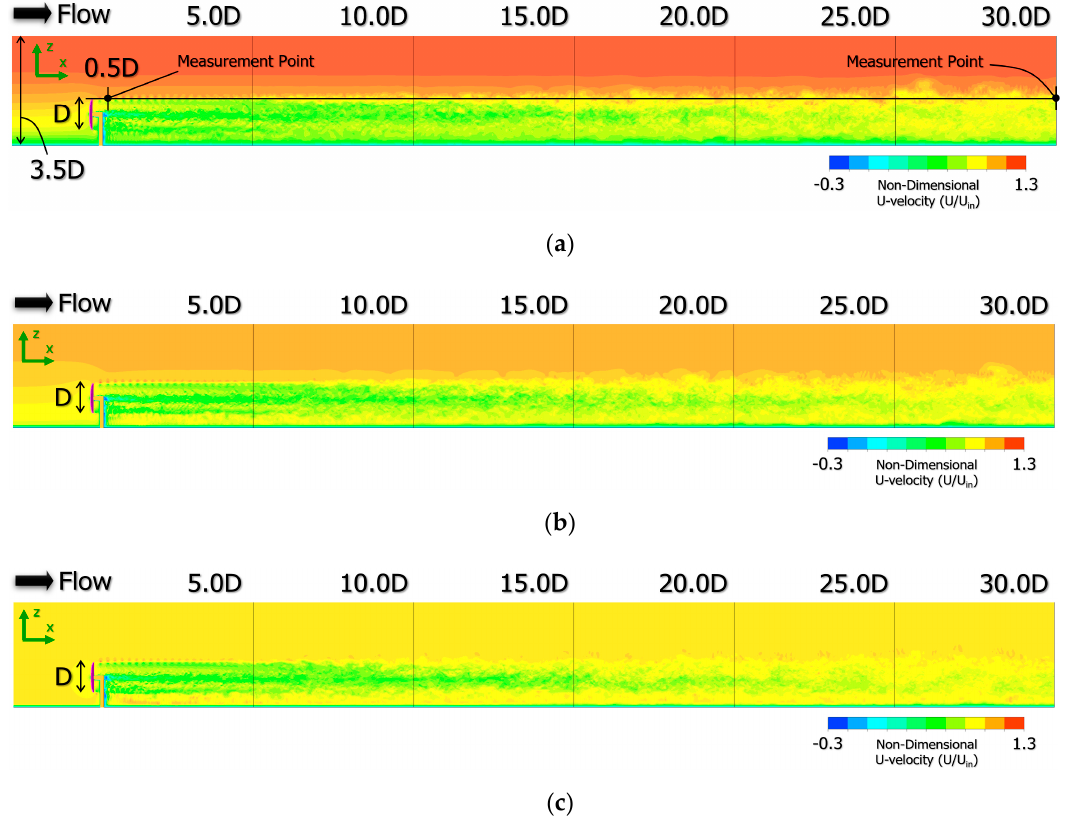
Figure 14. Spatial distribution of U-velocity for instantaneous flow field in the x–z plane (side view) at y = 0: ( a ) N = 4, ( b ) N = 10, and ( c ) uniform flow.